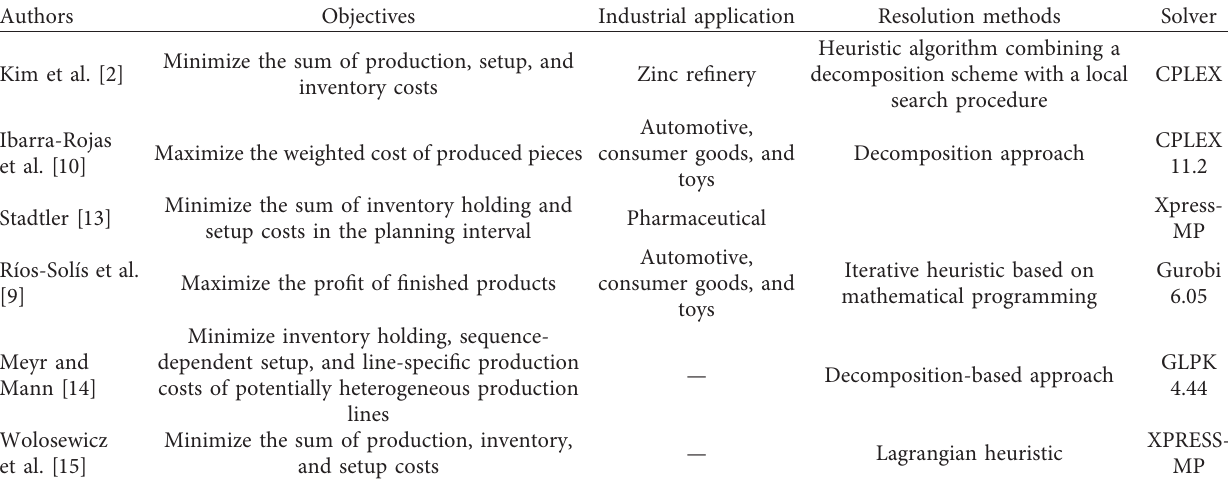
Table 1: Literature review of recent lot-sizing and scheduling